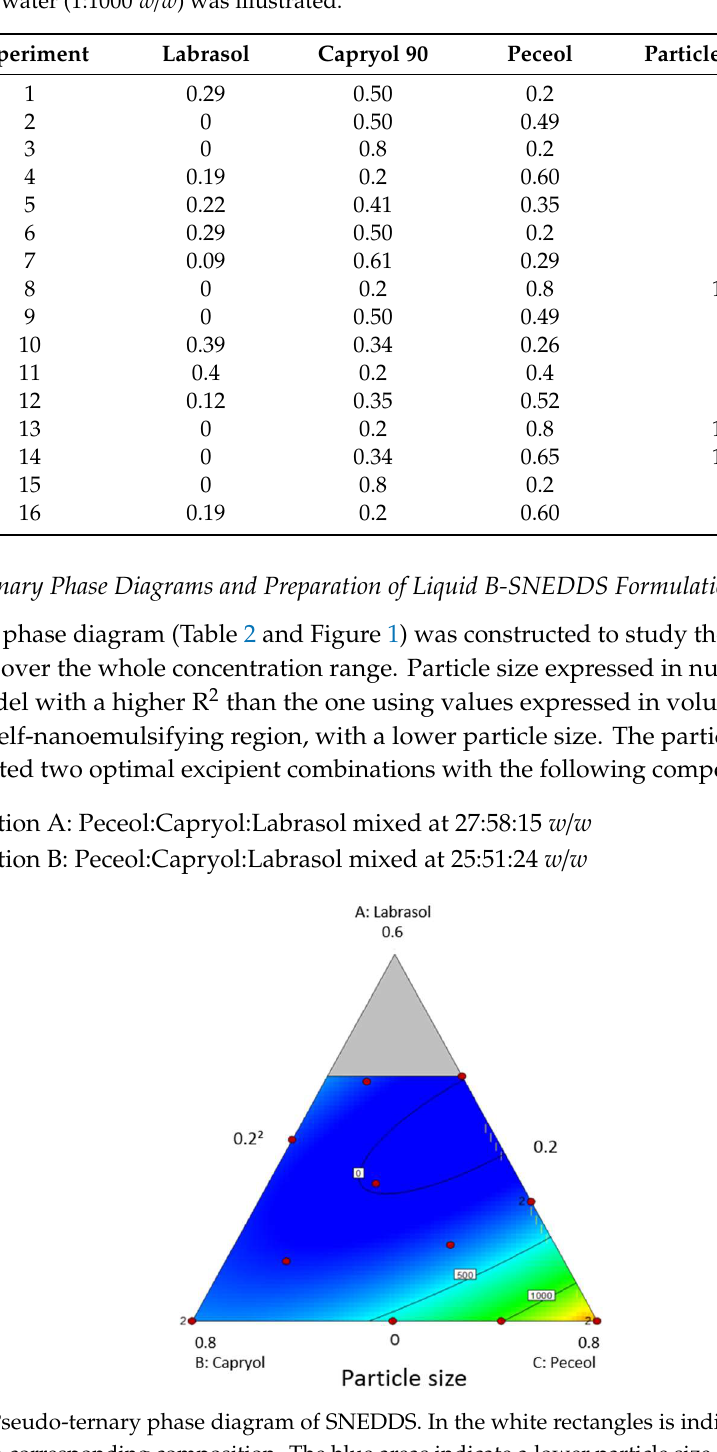
Table 3. Characterisation of the solid B-SNEDDS. Results are reported as mean ± SD ( n = 3). Code